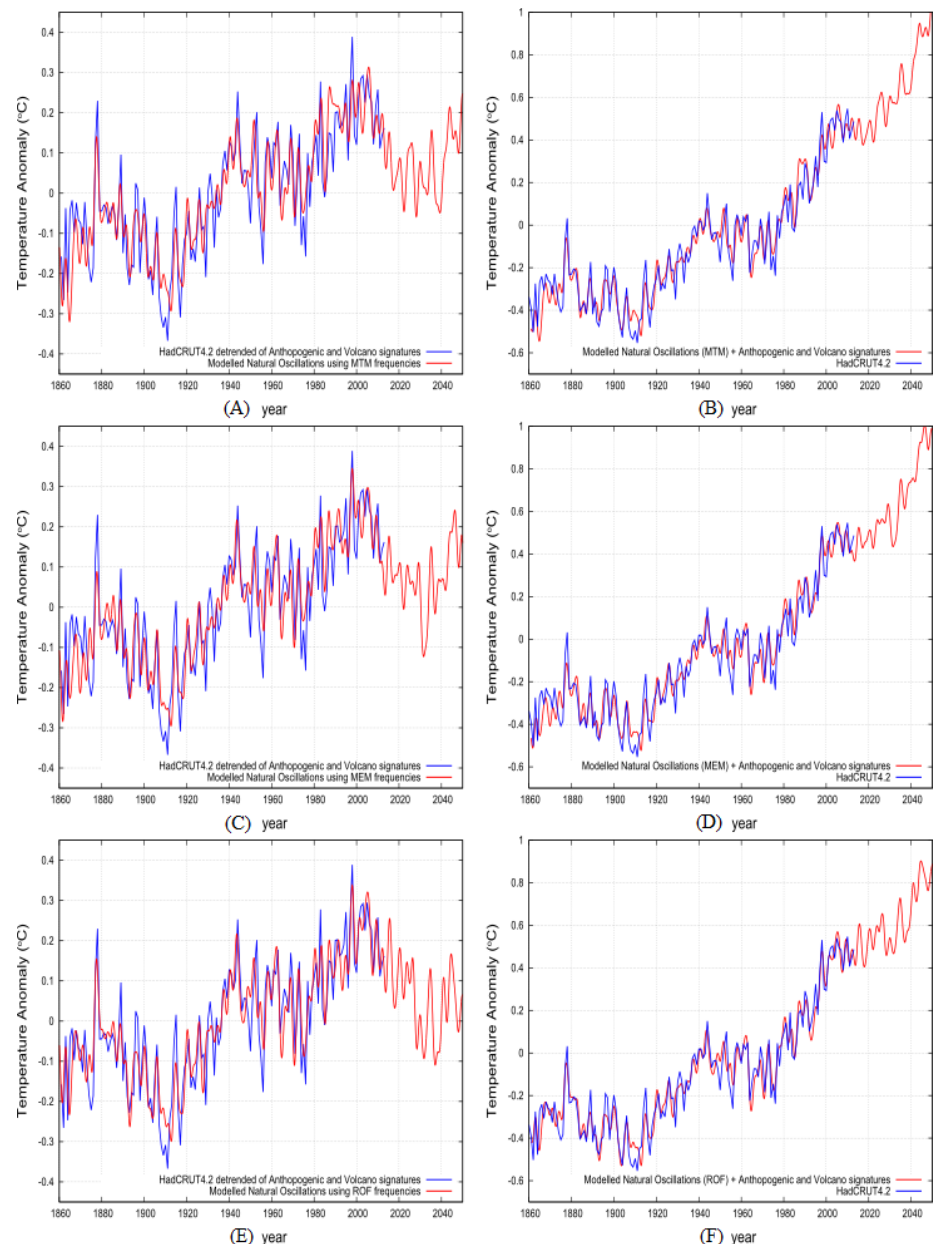
Figure 9. ( A , C , E ) show in blue the natural variability of the global surface temperature (Figure 8A, Equation (6)) versus the harmonic modeled using only the harmonic component of Equation (9), which also includes Equation (7), with the three parameter-sets (MTM, MEM and ROF) reported in Table 2. ( B , D , F ) show in blue the HadCRUT4 global surface temperature record versus the full climate model made of the observed oscillations plus the anthropogenic and volcano effects modeled by Equation (9) with the parameters reported in Table 2. The rmsr is between 0.06 and 0.07 ◦